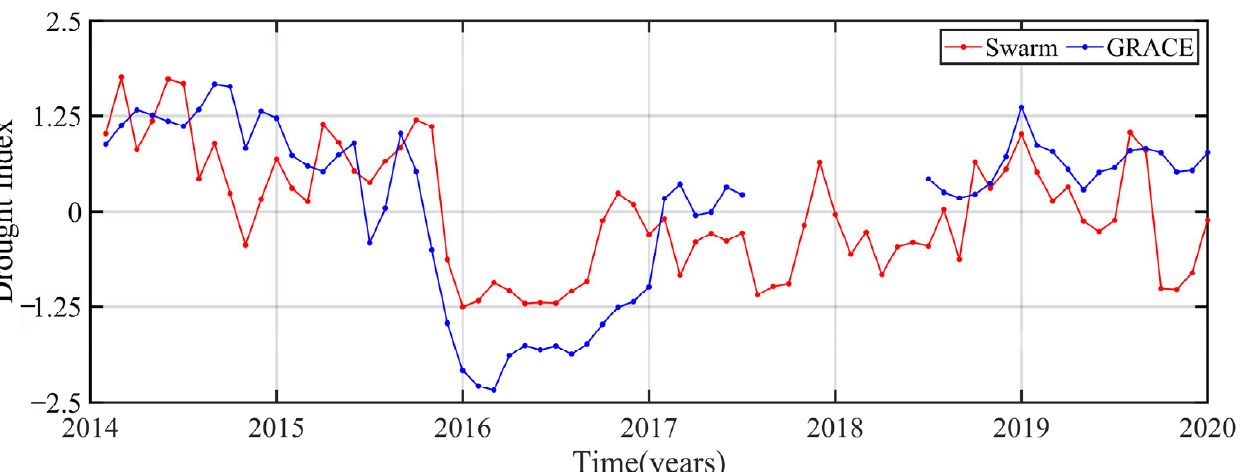
Figure 7. The spatial distribution of uncertainties of GRACE ‐ DSI and Swarm ‐ DSI in the ARB. Figure 8. The time ‐ series of GRACE/Swarm ‐ DSI, SCPDSI, SPEI ‐ 3, SPEI ‐ 6 and SPEI ‐ 12 in the ARB during 2003–2020.